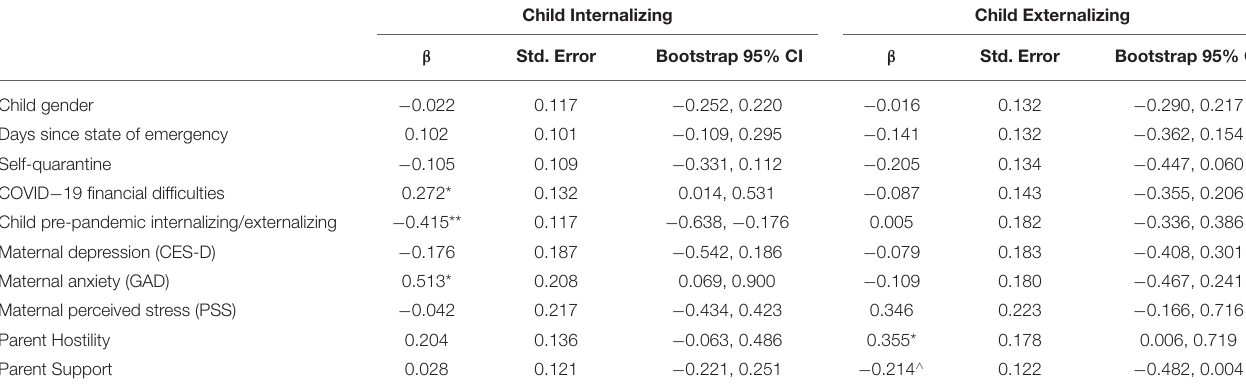
TABLE 3 | Linear regression results: parental mental health, stress, and parenting behavior in association with changes in child behavior problems. Child